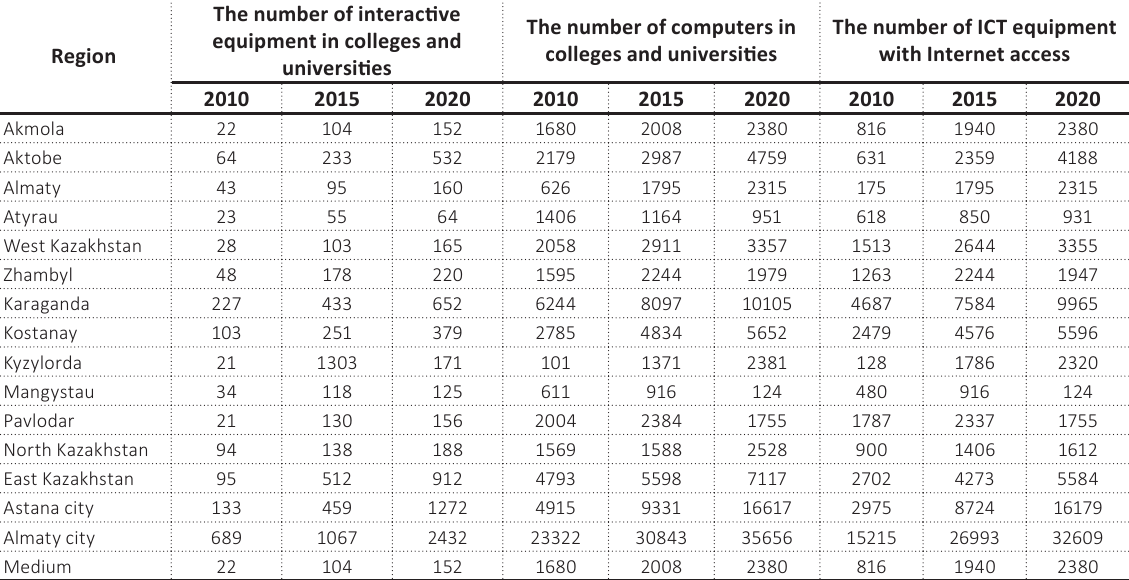
Table 3. Indicators of accessible ICT infrastructure at colleges and universities by regions Source: Authors’ elaboration based on Bureau of National Statistics